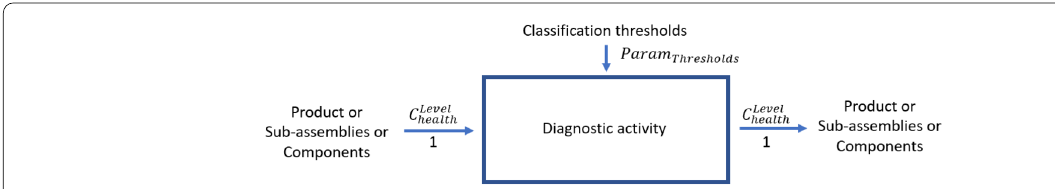
Figure 4 Input/Output of Diagnostic activity